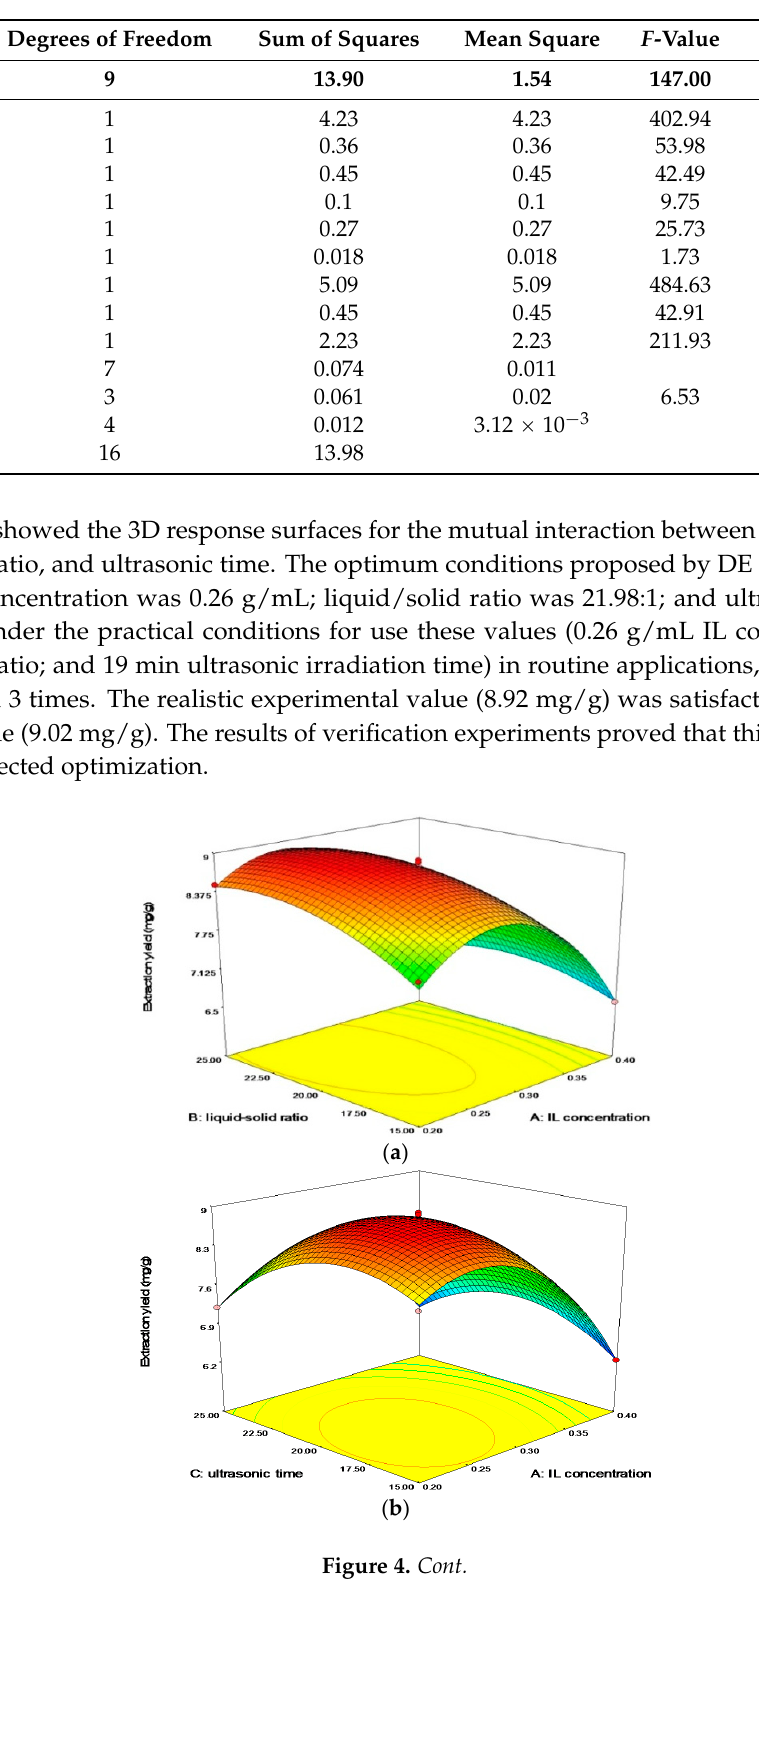
Table 2. Analysis of variance for the response surface quadratic regression model.